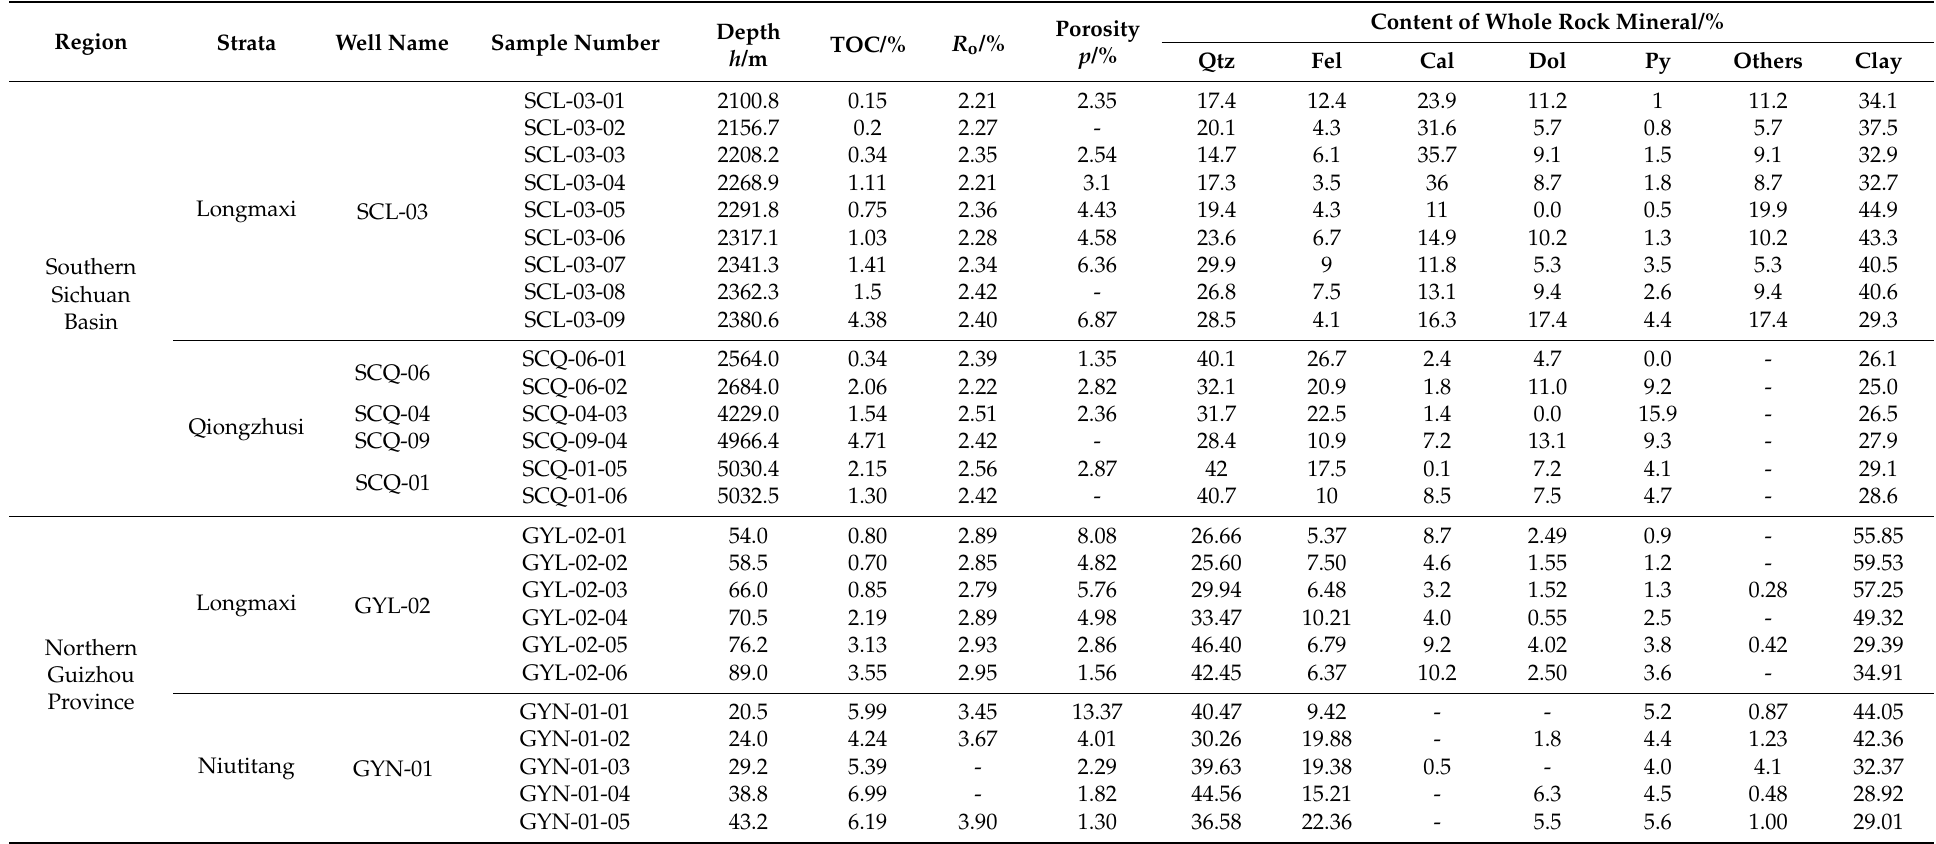
Table 1. Mineral composition and geochemical characteristics of shale samples of the Lower Cambrian from the upper Yangtze plate.